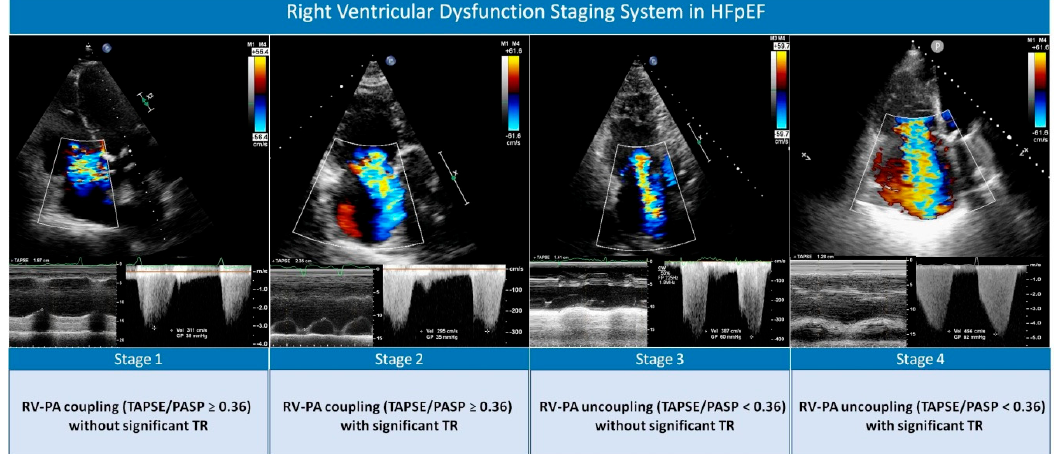
Figure 1. Proposed echocardiographic right heart dysfunction staging classification system based on right ventricular–pulmonary artery coupling and functional tricuspid regurgitation severity. HFpEF: heart failure with preserved ejection fraction; RV–PA: right ventricular–pulmonary artery; TAPSE/PASP: tricuspid annular plane systolic excursion to pulmonary artery systolic pressure ratio; TR: tricuspid regurgitation.